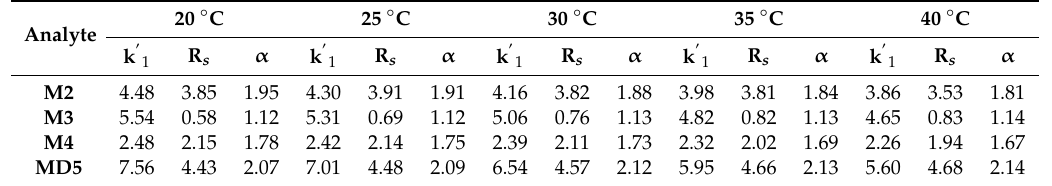
Table 1. E ff ects of the column temperature on the retention and Table 1. Effects of the column temperature on the retention and enantioseparation.